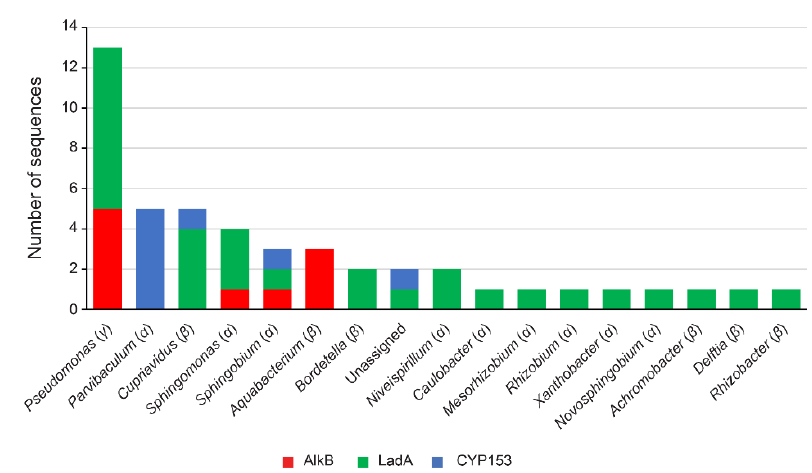
Figure 2. Number and taxonomic assignation at the genus level of the enzymes belonging to alkyl group hydroxylases; AlkB (alkane 1-monooxygenase), LadA (long-chain alkane monooxygenase), and CYP153 (cytochrome P450 family CYP153). Class adscription of the genera depicted is indicated under parenthesis. For additional information, see Supplementary Table S3.